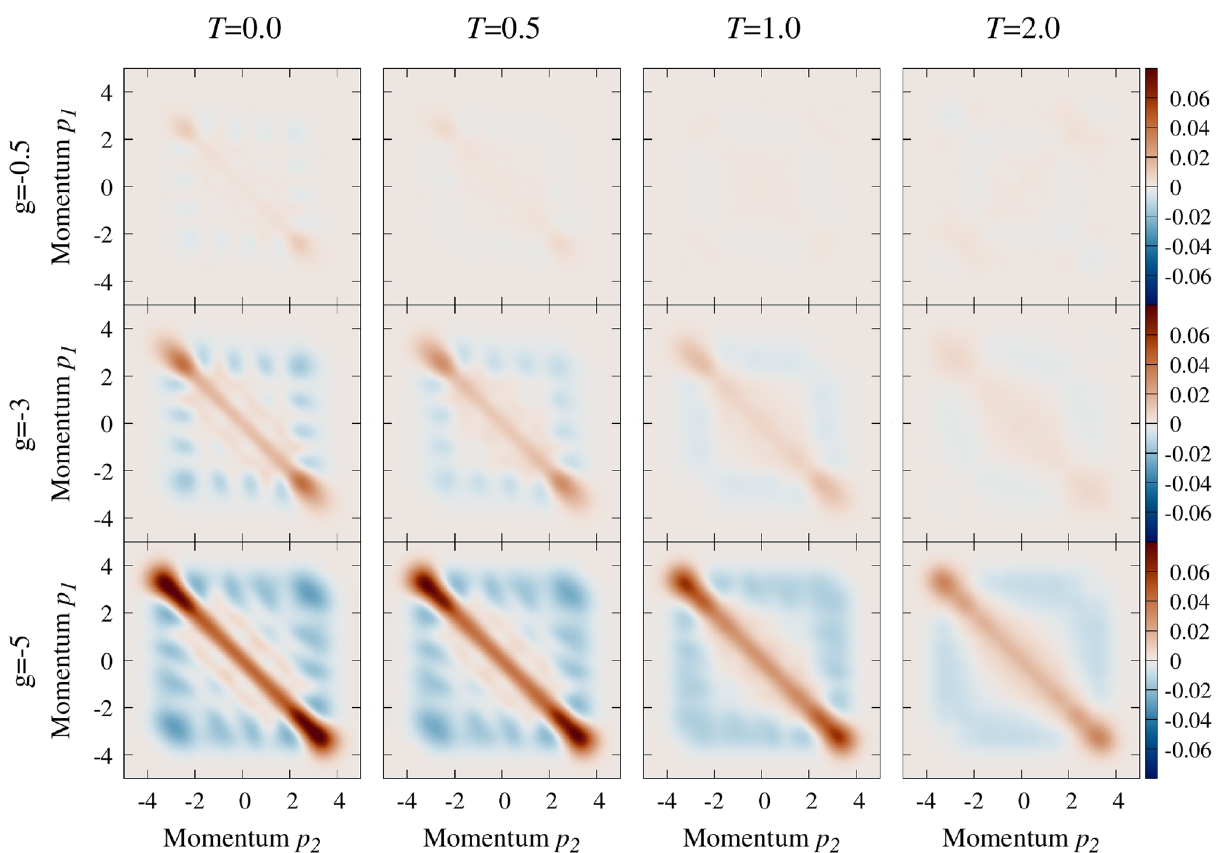
8 particles. Consecutive =